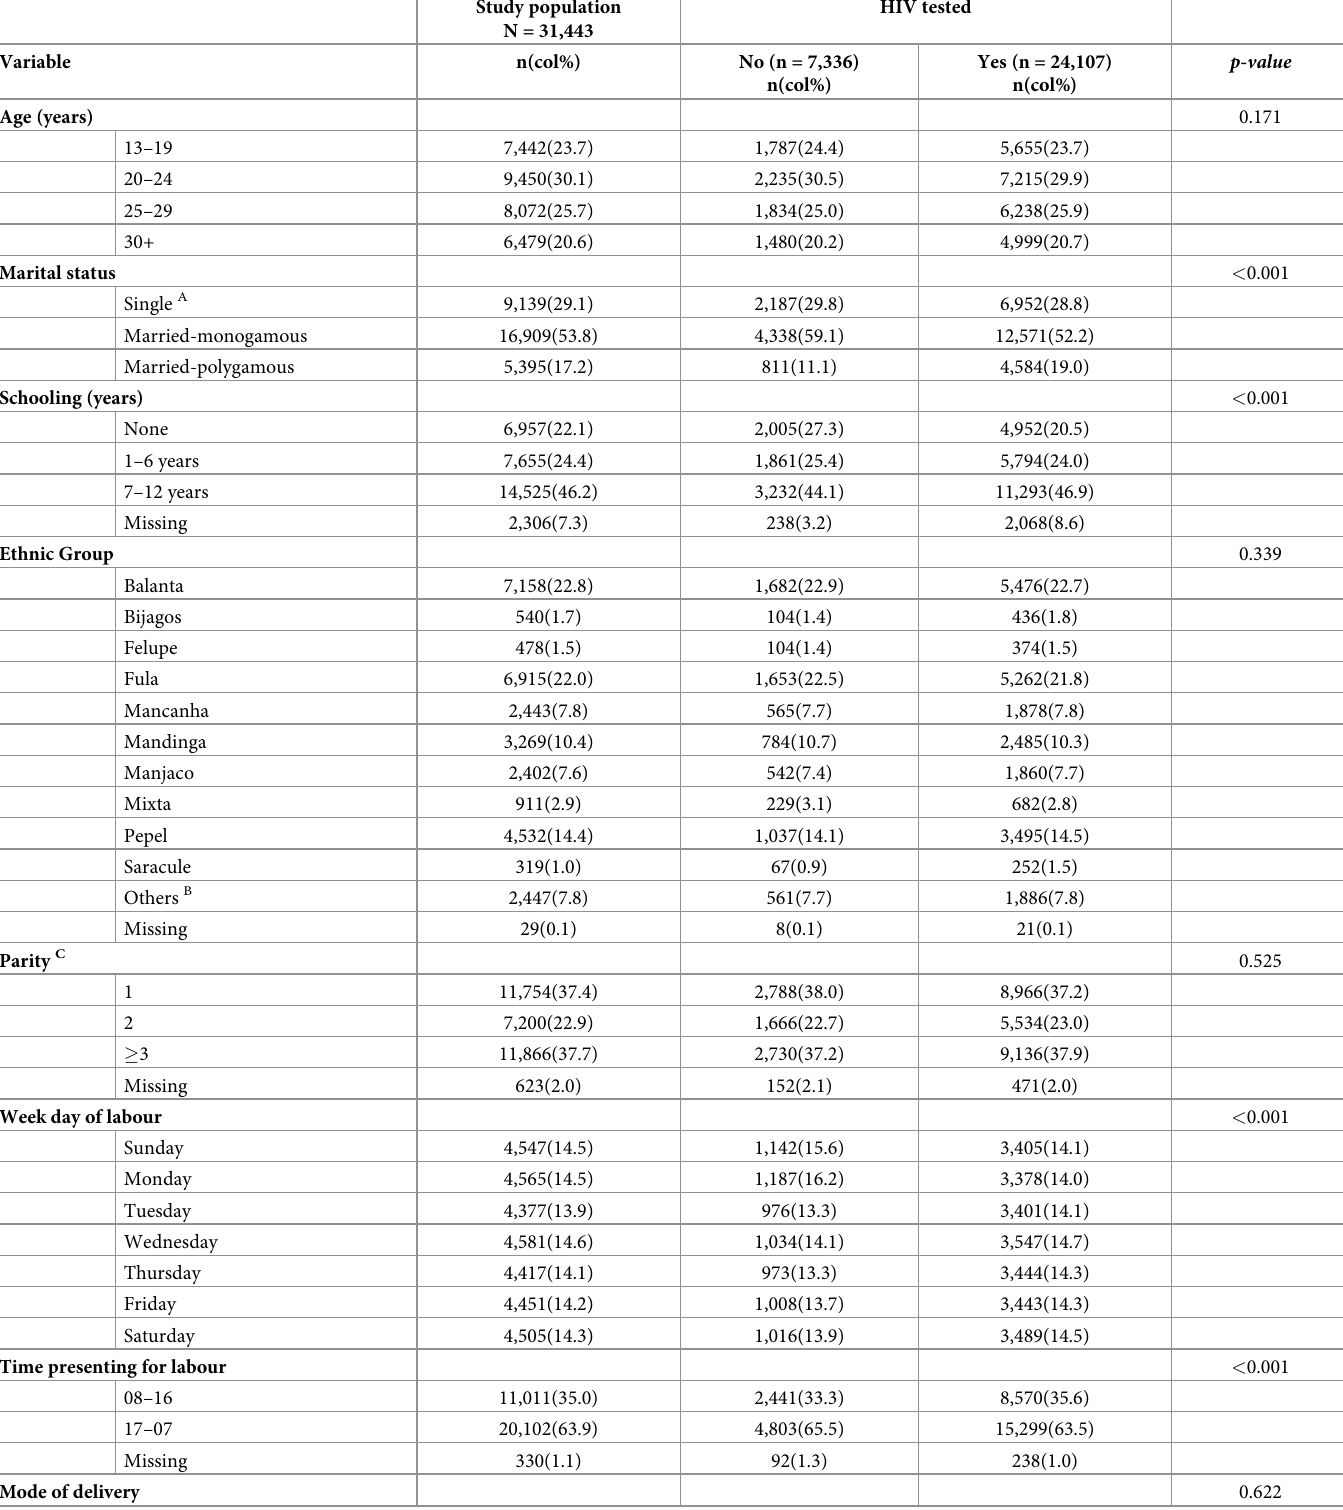
Table 1. Sociodemographic and clinical characteristics of pregnant